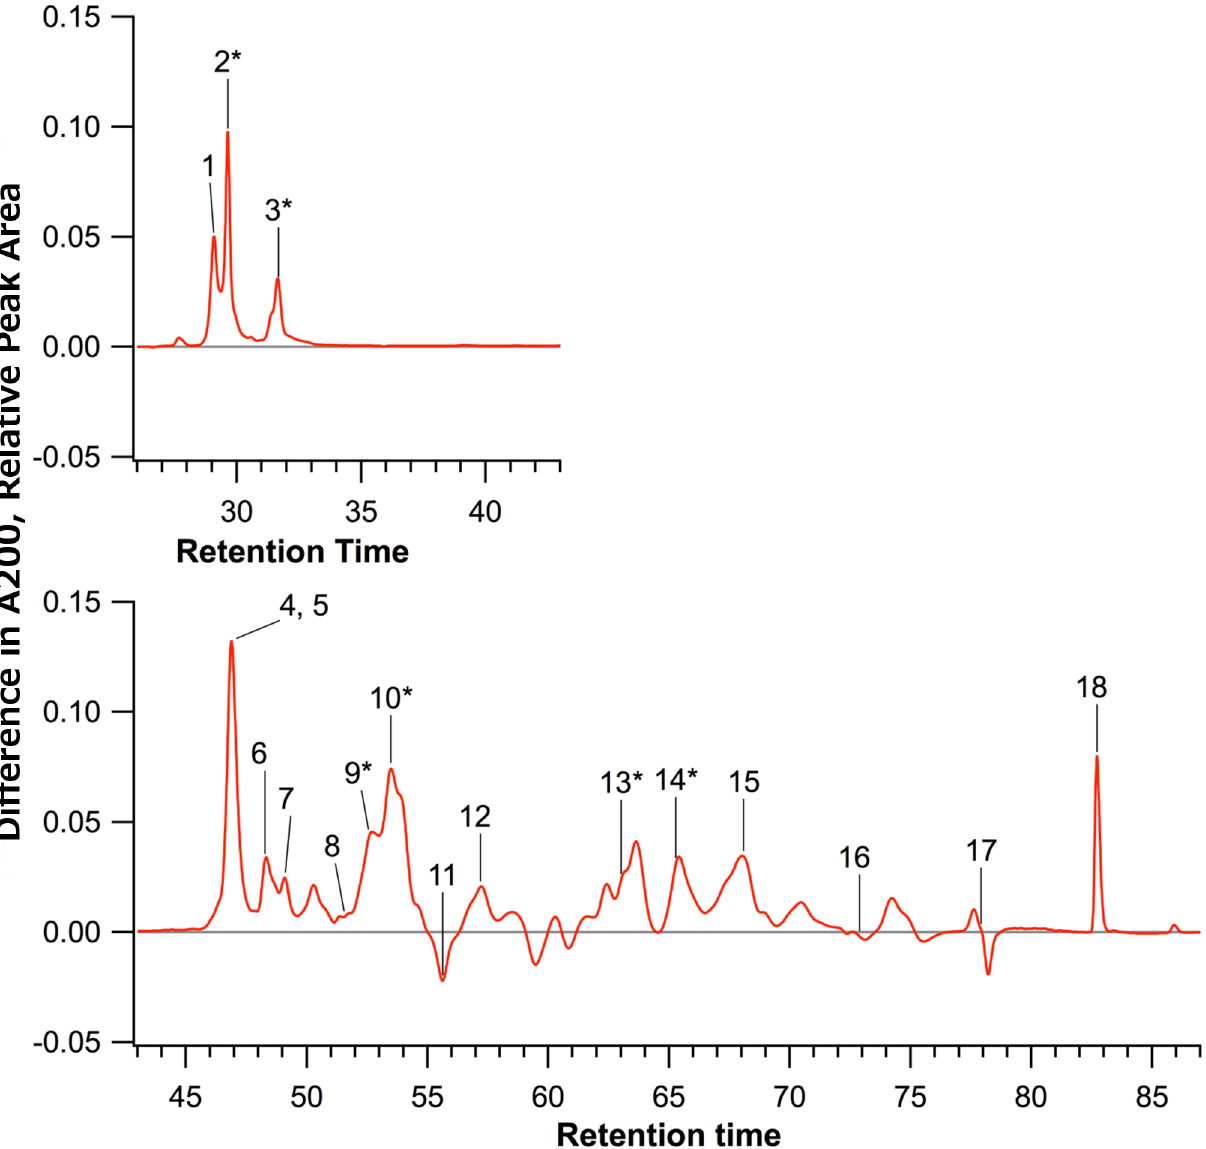
Fig 4. Composite HPLC traces. The red line is the mean of traces of the selected population minus the mean of the traces of the unselected population. Peak 2 is the 27kDa gamma zein, identified by comparison to known HPLC traces [17, 18]. Asterisks indicate peaks that were significantly higher in the selected samples ( α (cid:2)